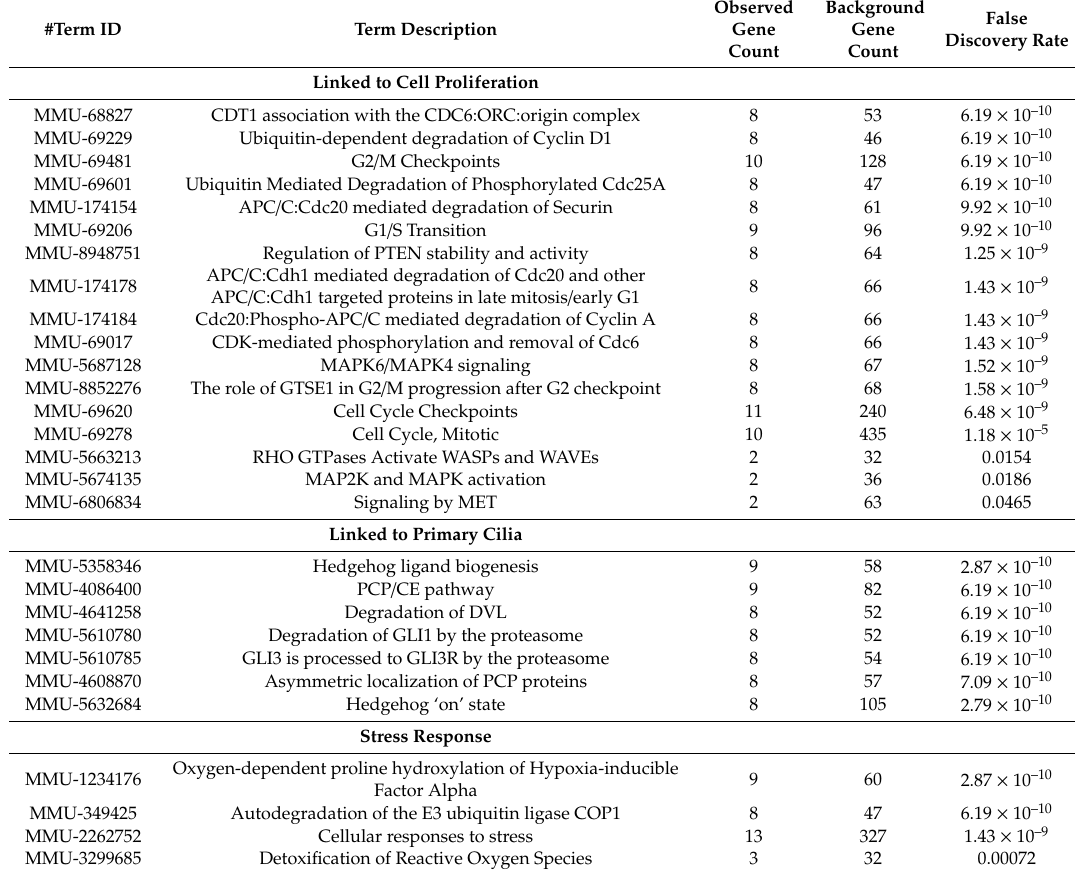
Table 1. Biological processes enriched by proteins in mIMCD EVs.